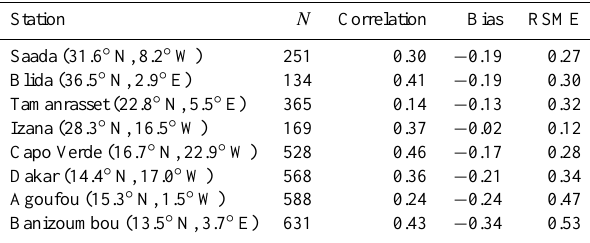
Table 2. Comparison of model results of dust optical thickness with daily aerosol optical thickness measurements at 8 AERONET sun- photometer stations, averaged for the years 2007 and 2008. “ N ” is the number of instances where daily AOT measurements are avail- able for the two years, “Correlation” is the correlation coefficient between model and observations, “Bias” is the absolute mean dif- ference between model dust optical thickness and measured AOT, “RSME” is the root mean square error. Station N Correlation